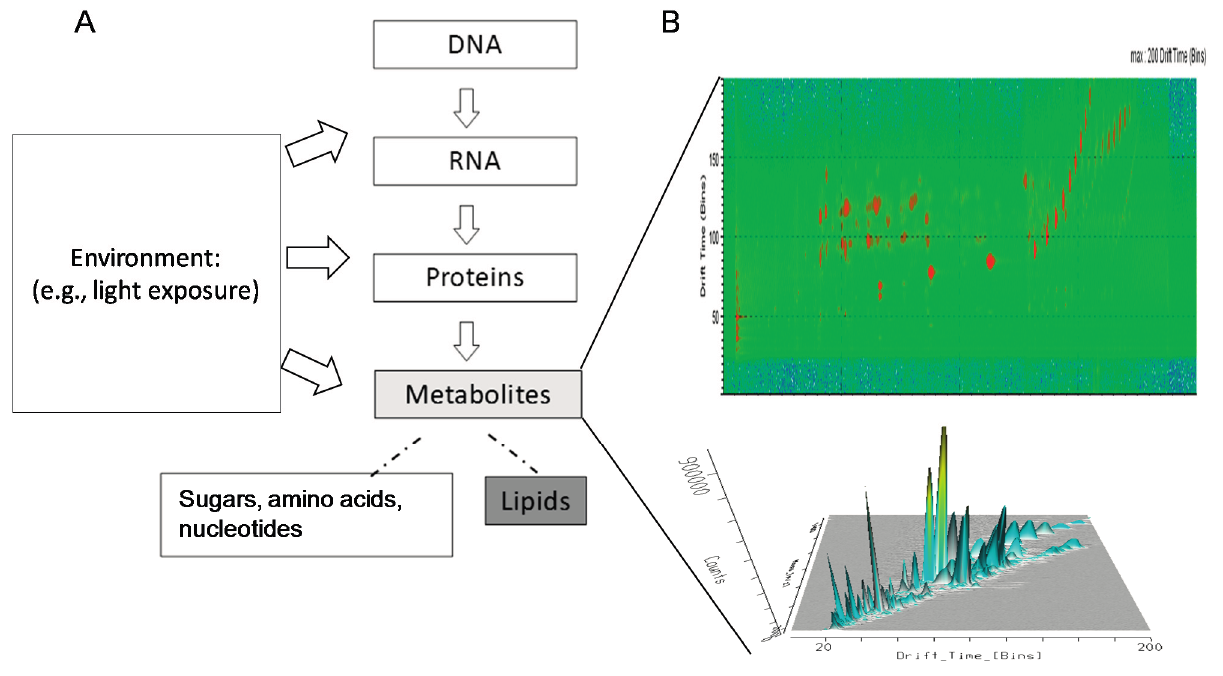
Figure 1. ( A ) Metabolomics aims to screen all the metabolites present in biological